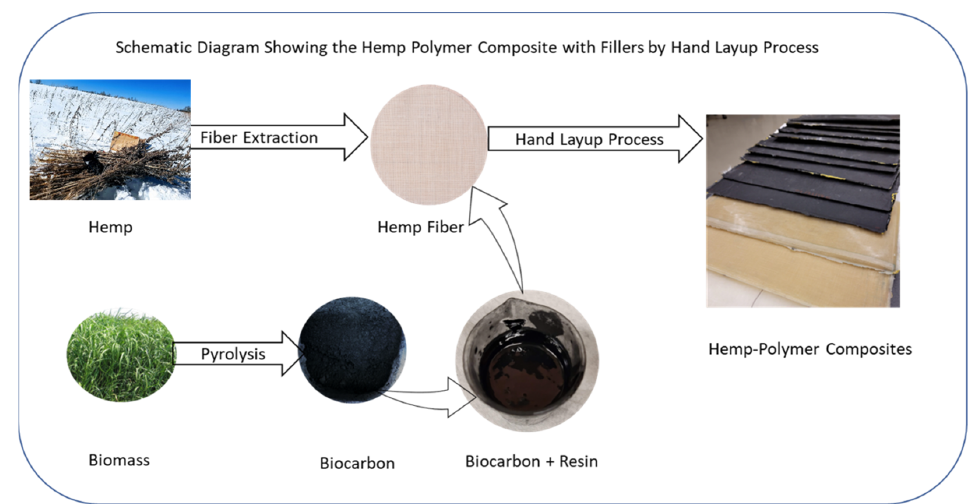
Figure 20. Composite sample preparation by hand-layup